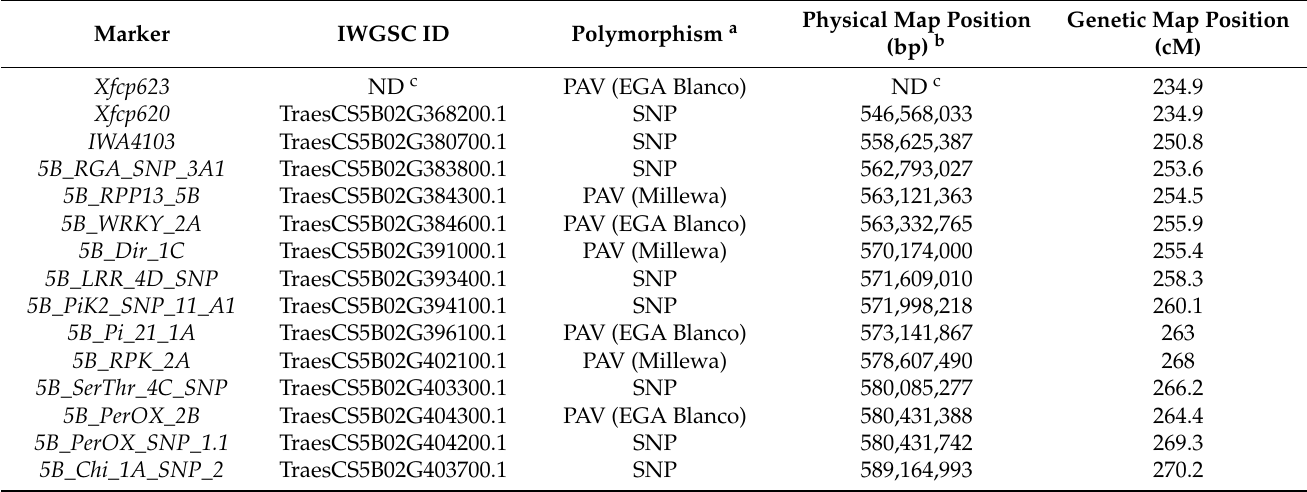
a Polymorphism represented by presence/absence variation (PAV) or single nucleotide polymorphism (SNP) between wheat cultivars EGA Blanco and Millewa. Absence of marker (null-allele) in parental variety is shown in brackets; b physical position of tile from where marker was designed; c ND: sequence not identified in the targeted QTL interval of the physical map in the IWGSC reference genome sequence of Chinese